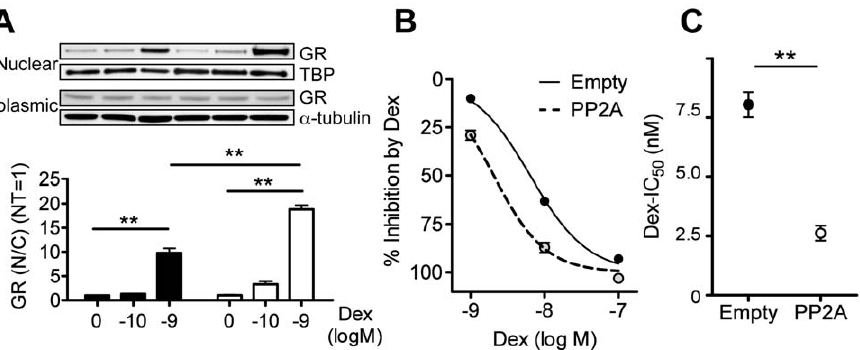
Figure 5. Effect of PP2A overexpression on glucocorticoid function in U937 cells. (A) Fold changes of GR nuclear translocation defined as the ratio of nuclear and cytoplasmic GR (N/C) over no Dex control (NT). Dexamethasone inhibitory response curve (B) and IC 50 values of Dex (C) on LPS-induced TNF a production. Values represent means 6 SEM (n=3): ** P , 0.01 between groups.